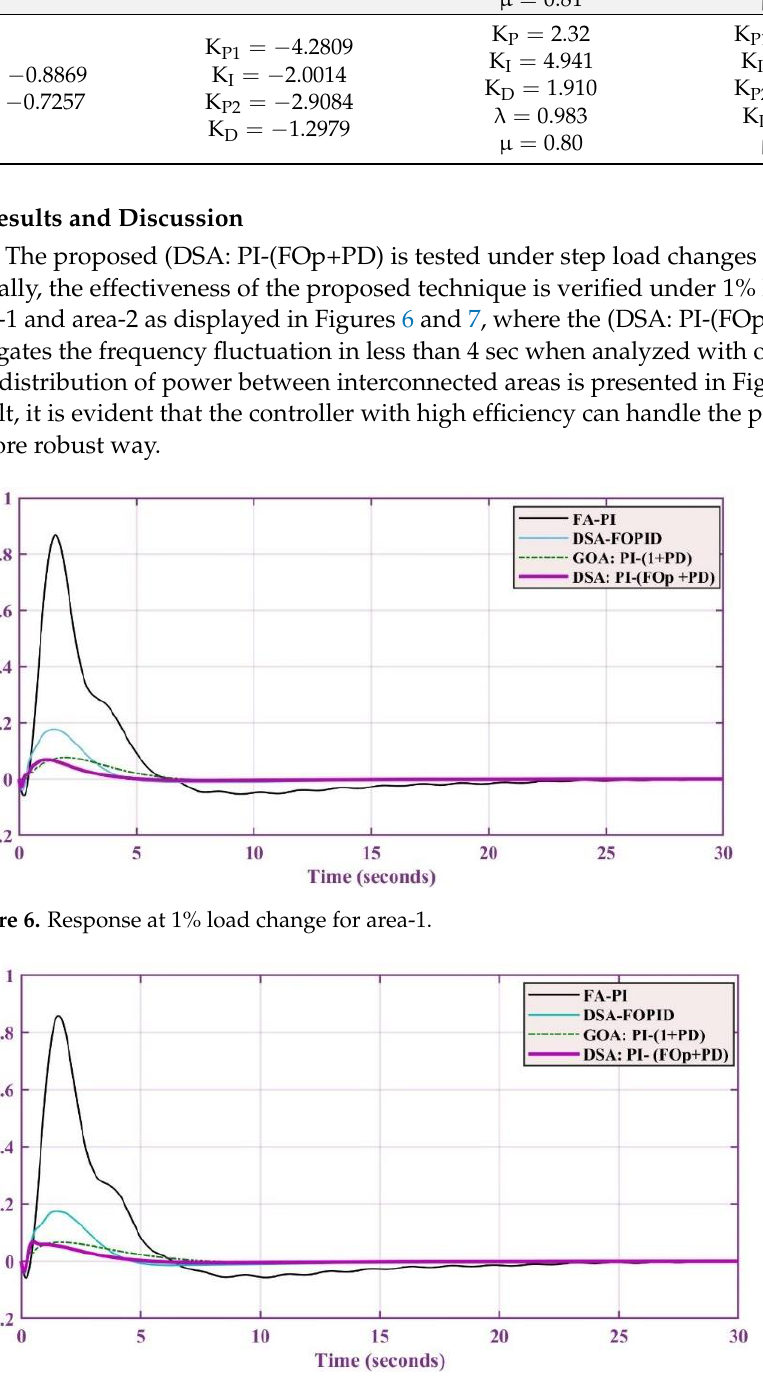
Table 2. Controllers’ parameters after 100 iterations.